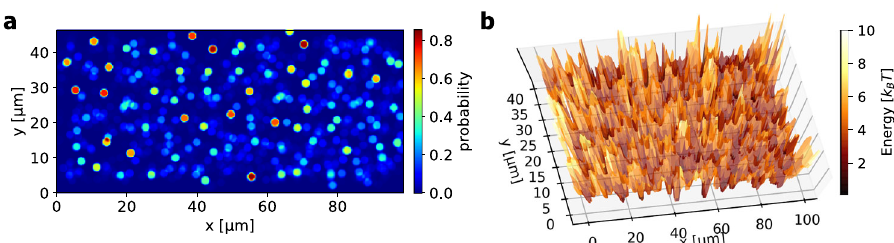
Fig. 1 Skyrmion energy landscape. a Occurrences of skyrmions in a 45 × 100 µ m² fi lm are measured at 312.5 K and − 88 µ T. The color scale represents the probability of pixels to be covered by skyrmions throughout the whole measured time. For example, at red positions, skyrmions were present around 80 % of the whole measurement time whereas the dark blue areas are rarely visited. The skyrmions explore the full space of the sample, only few single pixels are never covered by skyrmions. b Relative energy landscape surface in k B T determined from the probability distribution at 312.5 K in (